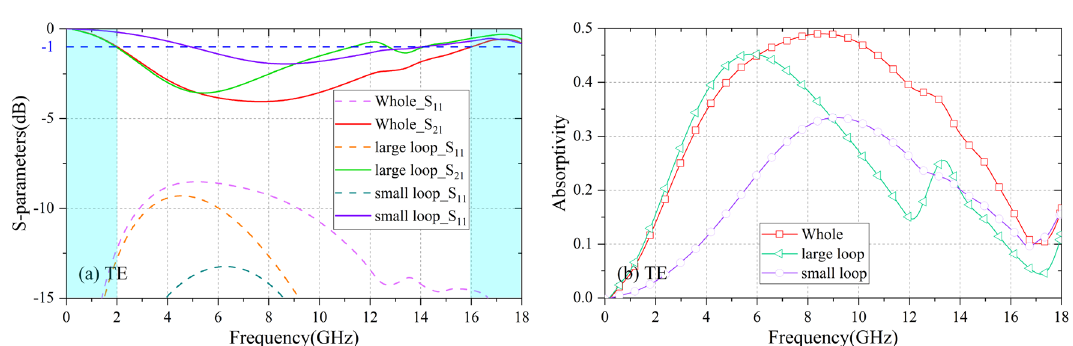
Figure 4. At normal incidence, frequency response and absorptivity of concentric rings, single large resistive loop, and single small resistive loop CA sheets. Reflection coefficient R/Transmission coefficient T/Absorptivity A of proposed CA sheet (R =|S 11 |, T =|S 21 |, A = 1 −|S 21 | 2 −|S 11 | 2 ). P = 22.0 mm, Rad_out = 9.0 mm, Rad_ in = 6.0 mm, w = 0.5 mm, h 3 = 0.13 mm, R out = 140 Ω, R in = 120